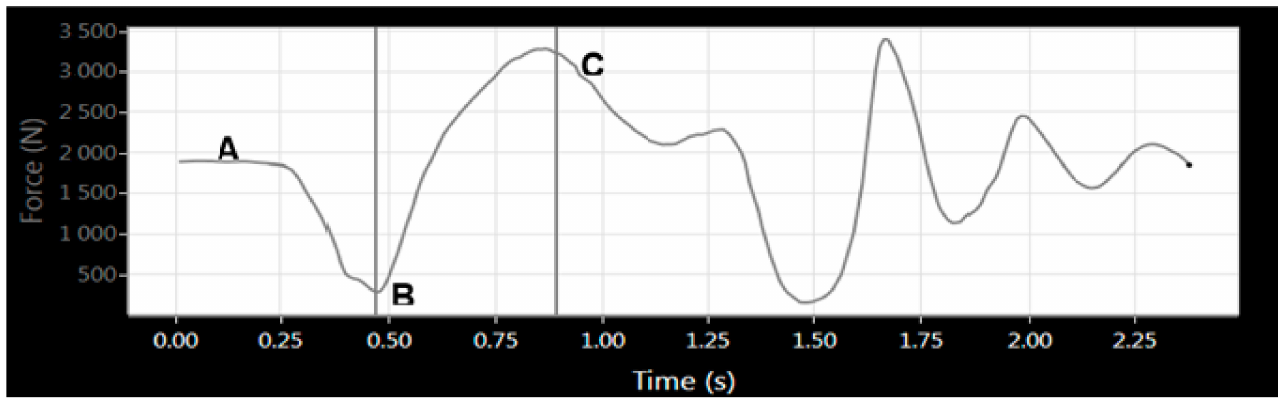
Figure 1. Example of a force trace during an incremental eccentric back squat with a trained rugby union athlete. ( A ) rep- resents the standing position with the barbell held across the trapezius muscles. The vertical line at ( B ) is the point of minimum force and is considered the beginning of the eccentric phase. ( C ) coincides with the point of lowest displacement and the end of the eccentric